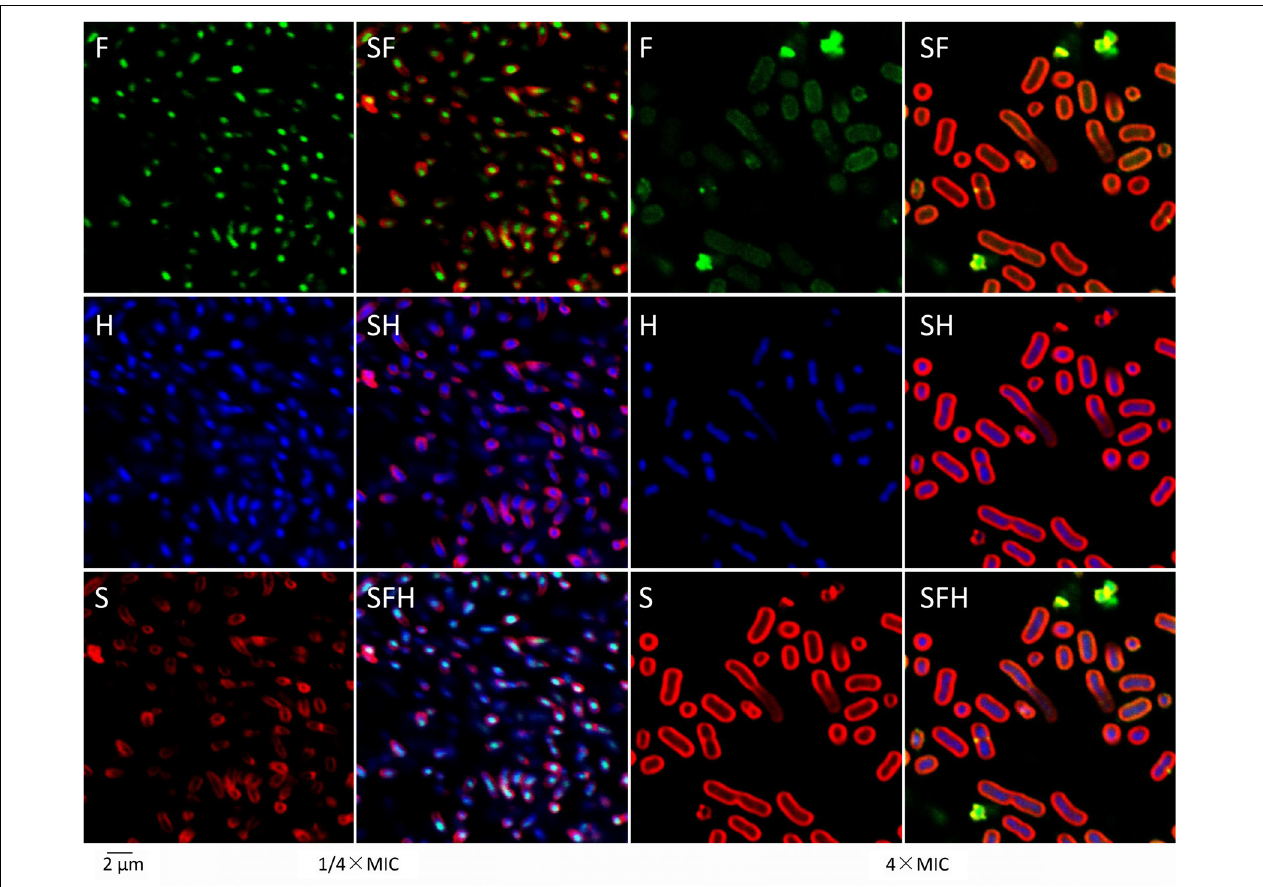
FIGURE 4 | Localization of tachyplesin III with confocal laser-scanning microscopy. First, 1 × 10 7 MDR clinical isolates of A. baumannii strain 1408 were incubated with 1/4 × MIC (2 µ g/ml) or 4 × MIC (32 µ g/ml) N-terminally tagged tachyplesin III in LB medium at 25 ◦ C for 1 h. After centrifugation at 3000 g for 10 min, cells were resuspended with the same volume PBS and incubated with 20 µ g/ml Hoechst (Sigma) at room temperature for 20 min. After another centrifugation at 3000 g for 10 min, cells were resuspended with the same volume of Hank’s solution (8 g/L NaCl, 0.4 g/L KCl, 1 g/L glucose, 60 mg/L KH 2 PO 4 , 47.5 mg/L Na 2 HPO 4 , pH 7.2) and incubated with 20 µ g/ml SynaptoRed C2 (Tocris Bioscience) on ice for 1 min. Confocal laser-scanning microscopy was performed with excitation and emission wavelengths, respectively, of 488 nm and 530 nm for FITC, 352 nm and 461 nm for Hoechst, and 515 and 640 nm for SynaptoRed